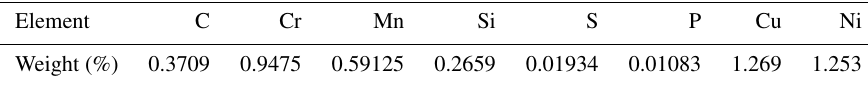
Table 1. Chemical composition of material. Element C Cr Mn Si S P Cu Ni Weight (%) 0.3709 0.9475